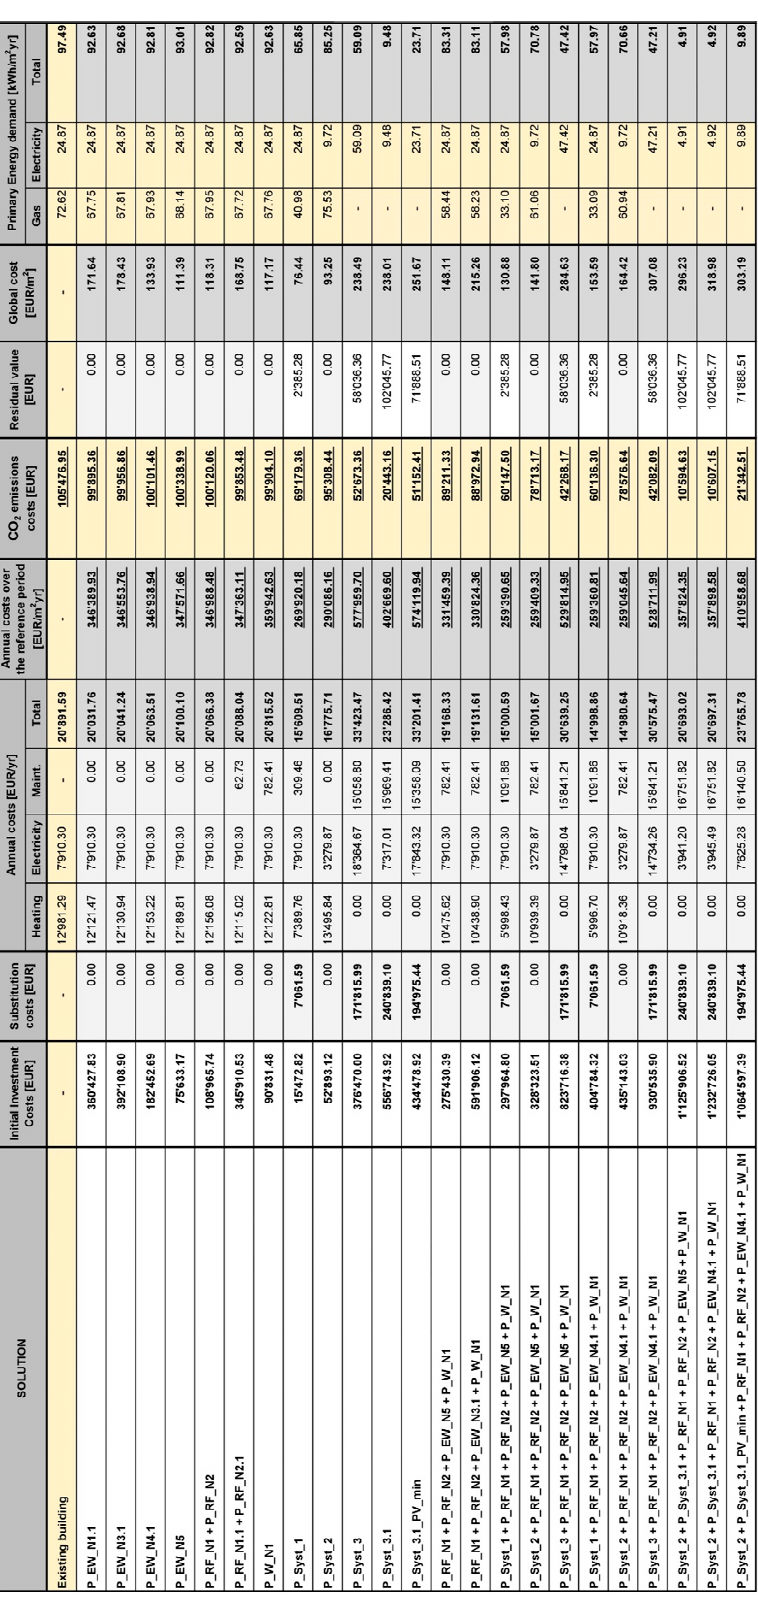
Figure A4. Summary table of cost-optimal methodology for macroeconomic scenario with discount rate equal to 4% for Poliziano school.